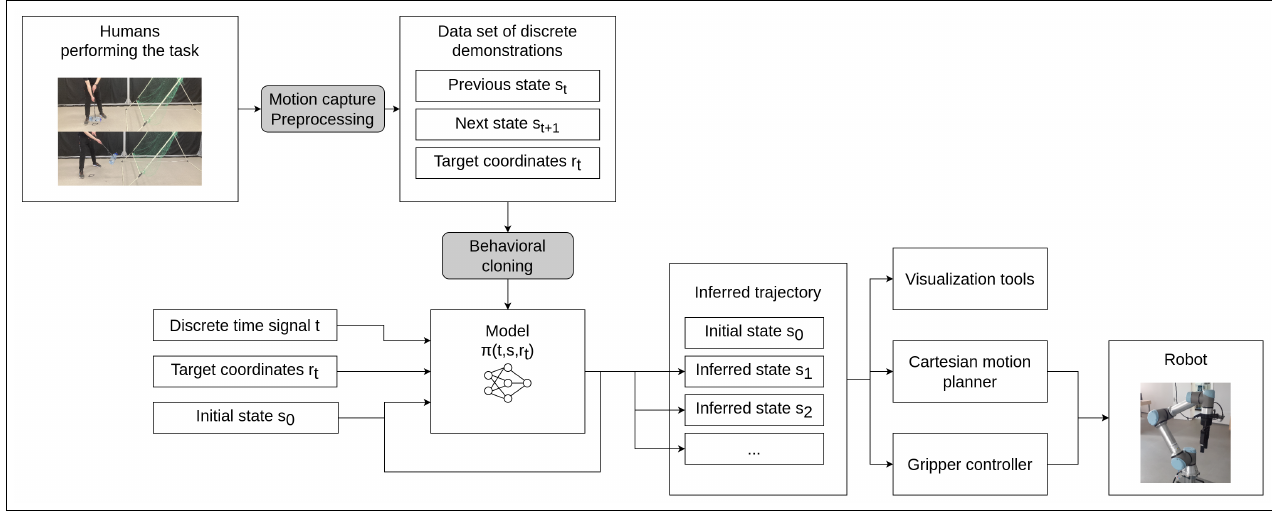
Figure 1. A high-level overview of the proposed approach. Demonstrations are recorded with motion capture equipment, a split and cropped data set augmented with target coordinates, and a gripper actuation signal is created. This is used to train neural network models in behavioral cloning. When operating in the open-loop regime, prior model outputs are used to autoregressively predict subsequent states. The resulting sequence can then be fed into a Cartesian motion planner to control a